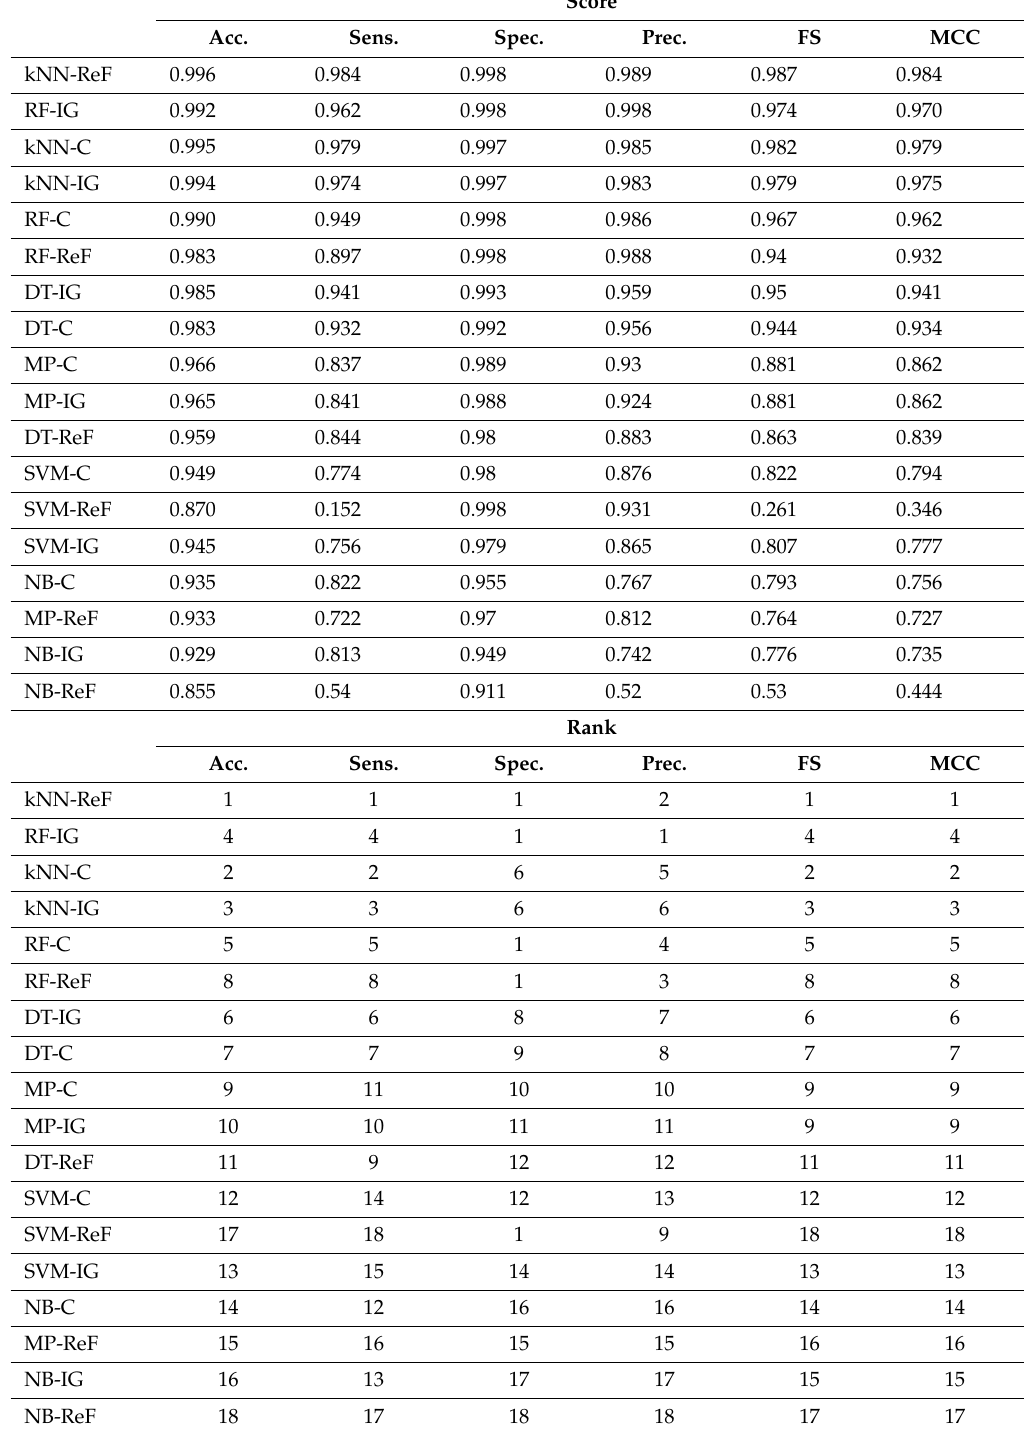
Table 3. Classification method and feature selection combination sorted by summed rank (best to